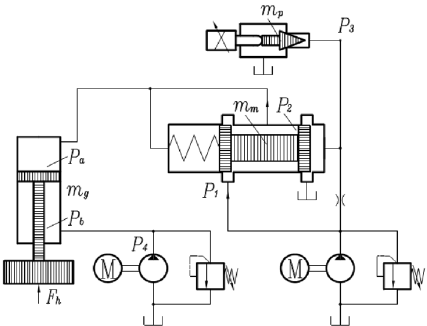
Figure 3. Hydraulic